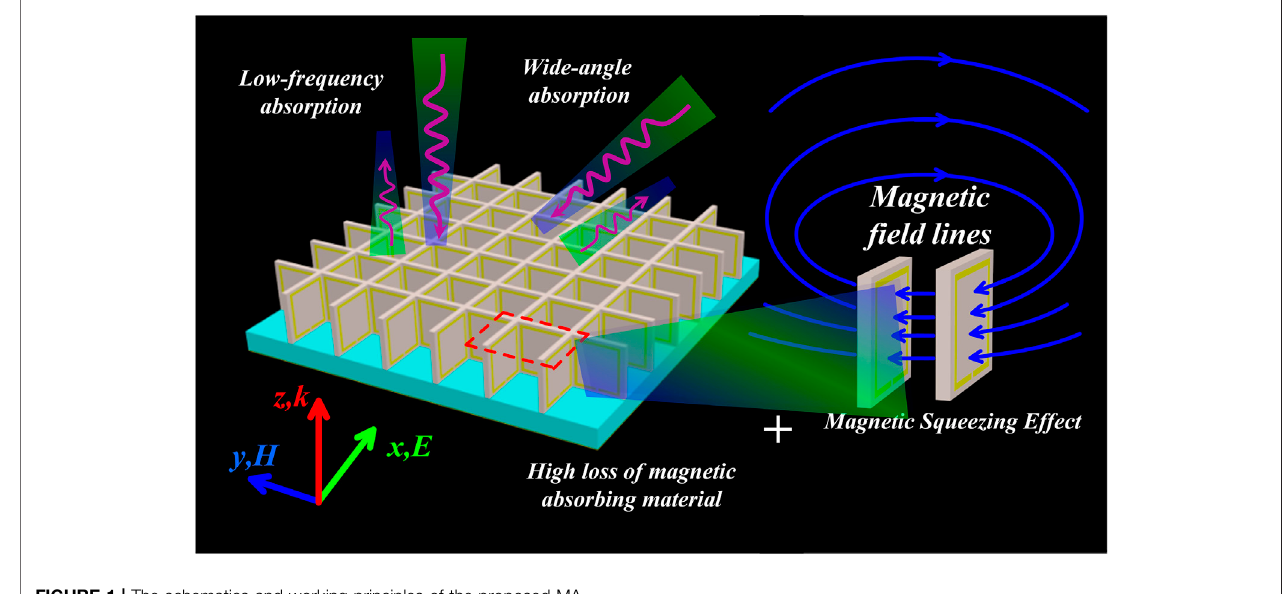
FIGURE 1 | The schematics and working principles of the proposed MA.